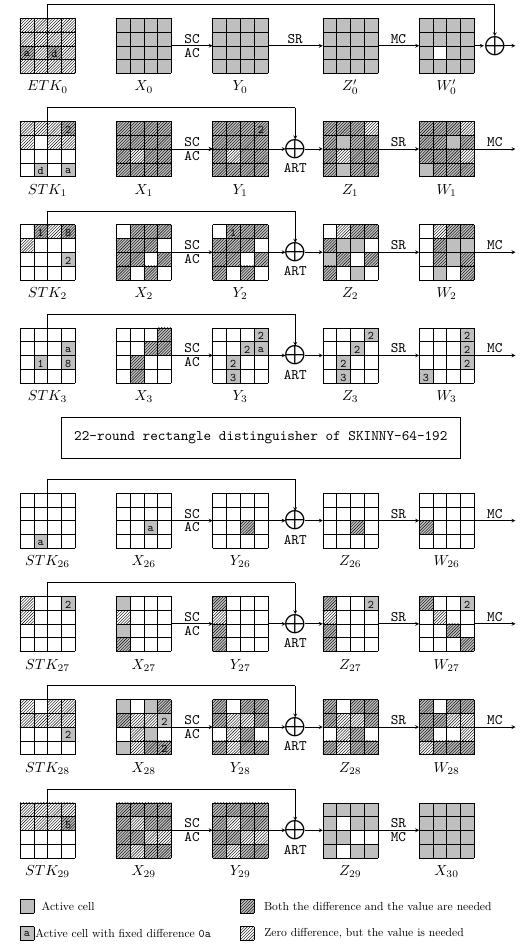
Figure 7: The 30-round attack against SKINNY-64-192